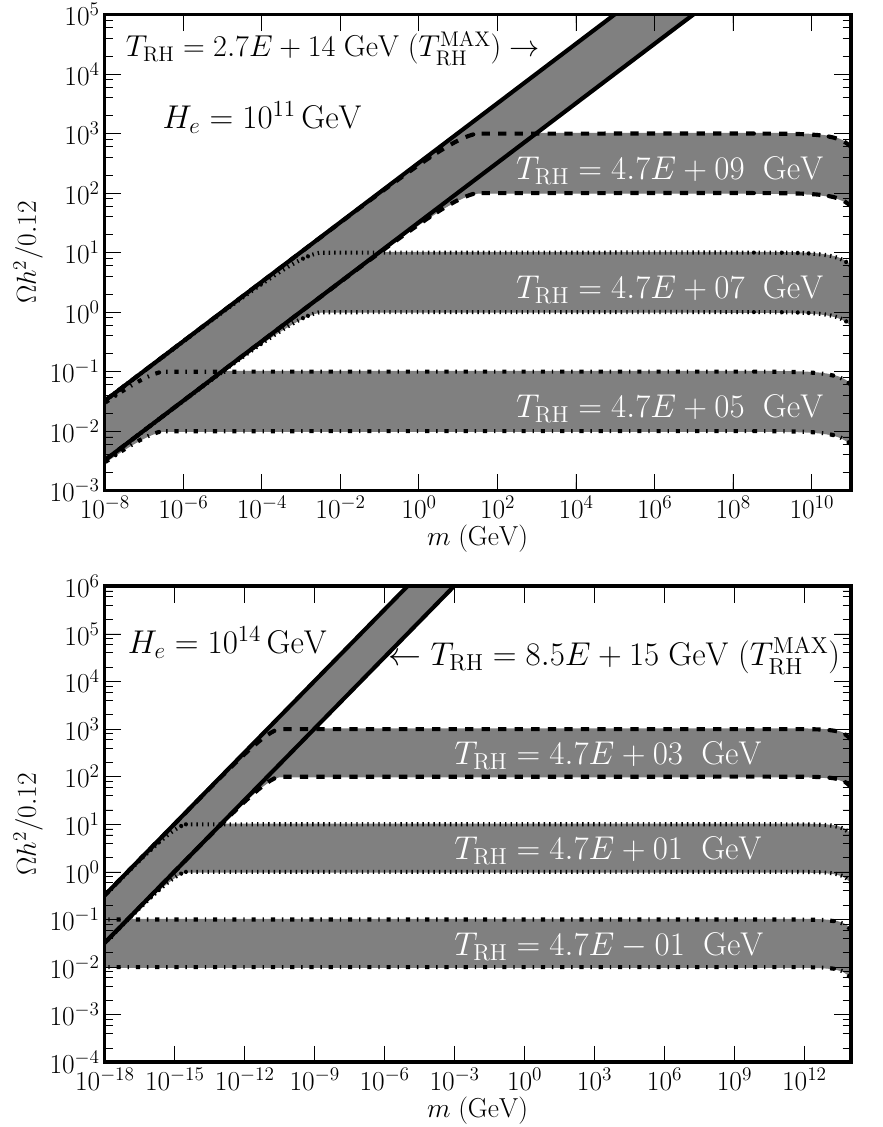
Figure 7 . The relic abundance of longitudinally-polarized dark photon dark matter, Ω h 2 , as a function of its mass, m , and the reheating temperature, T RH , for two values of the inflationary Hubble scale, H e . The asymptotic behavior is captured by eqs. (6.3) and (6.4). The band illustrates a weak dependence on the inflationary model (for a given H e